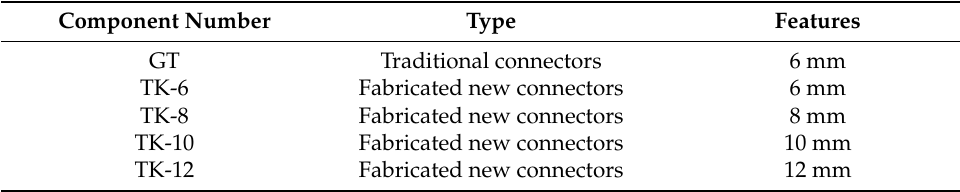
Table 5. Simulation connector type.